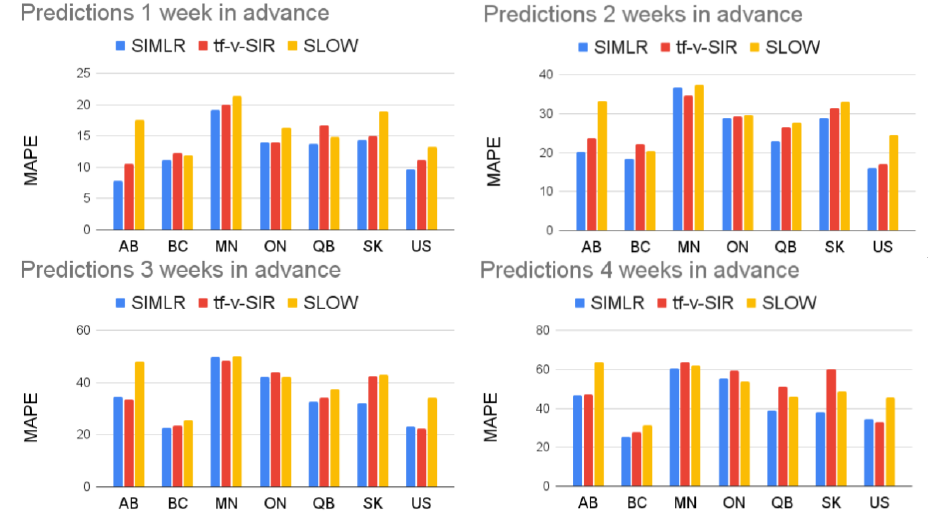
Figure 6. Comparison of SIMLR, SIR model with time-varying parameters, and SLOW. Table 1 contains the numerical